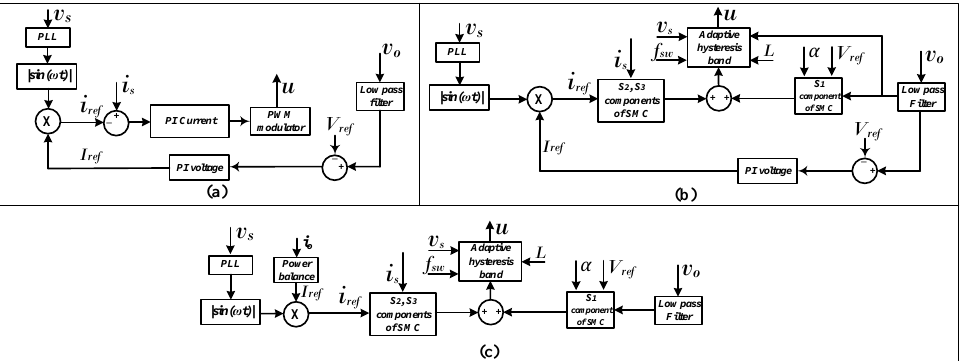
Figure 7. Block diagram of the control system: ( a ) classical cascade PI controller; ( b ) hybrid PI-SMC; and ( c ) proposed SMC.